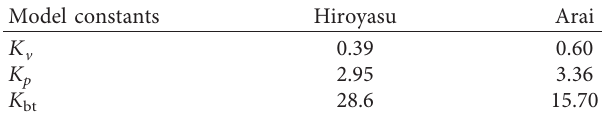
Table 3: Model constants for spray tip penetration.